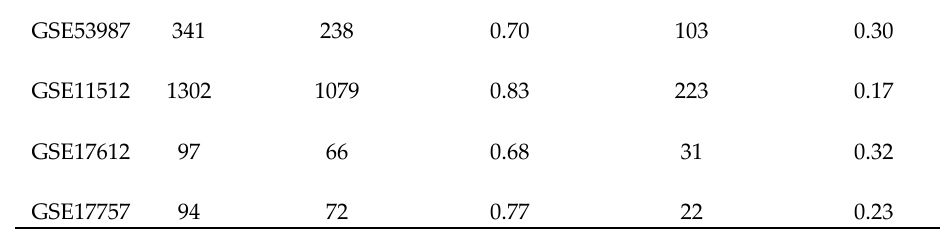
Figure 3. ( A ) Venn diagram of DEGs identified from the individual analysis (GSE11512, GSE17612, GSE53987, and GSE17757) and from the meta-analysis. The meta-analysis identified 1218 genes that were identified by the individual analysis (intersection of the black ellipse with others four ellipses) and 598 additional genes that were not identified in any individual analysis. ( B ) Number and proportion of DEGs from individual analysis and detected by the meta-analysis. “In Meta-analysis” means the DEGs from individual analysis that were preserved in the meta-analysis, while “Out Meta-analysis” means the DEGs from individual analysis that were not present in the meta-analysis. Table 2. Summary of number and direction of the change of DEGs detected in the analysis.